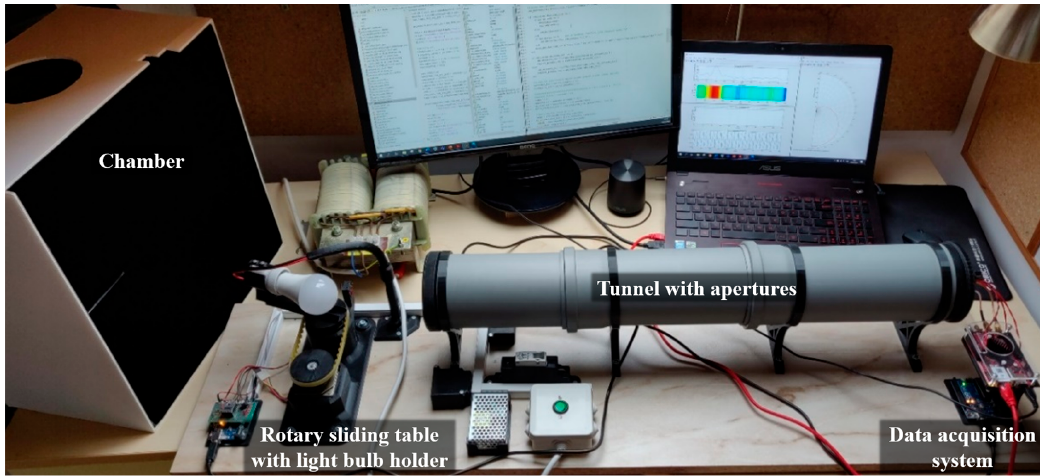
Figure 1. Measuring system.